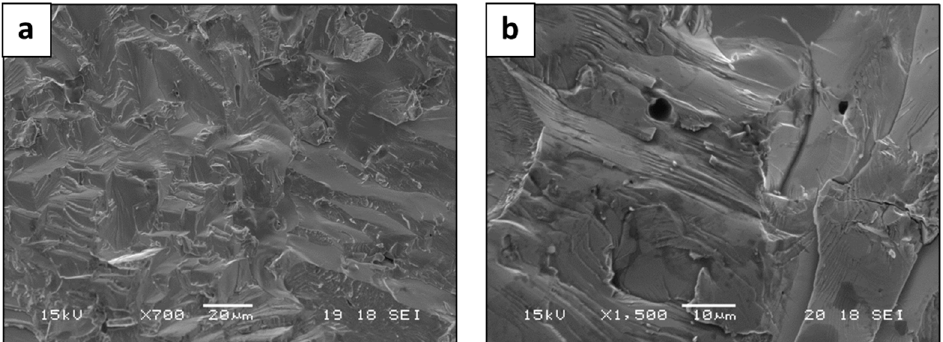
Figure 10. Fractography analysis of HEA WTaMoNbV produced by AMF process, showing trans- granular fracture.